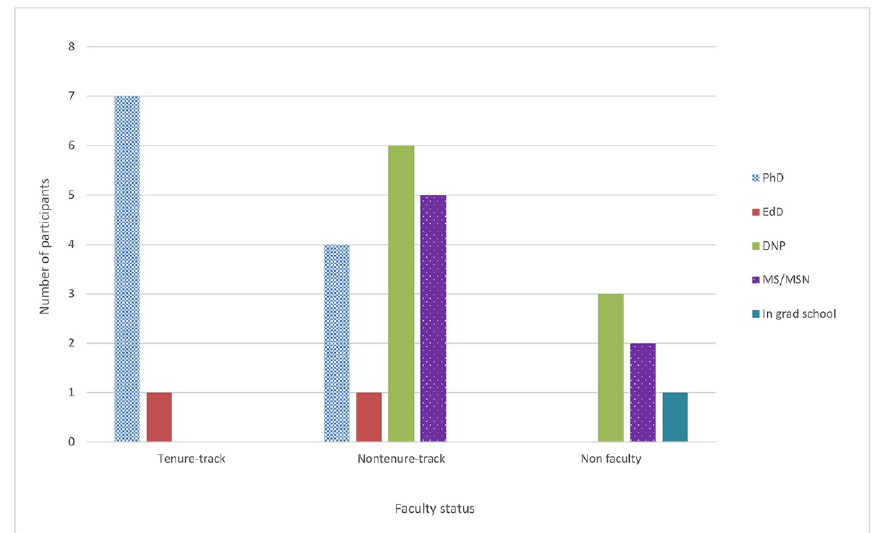
Figure 1 Degree earned by faculty